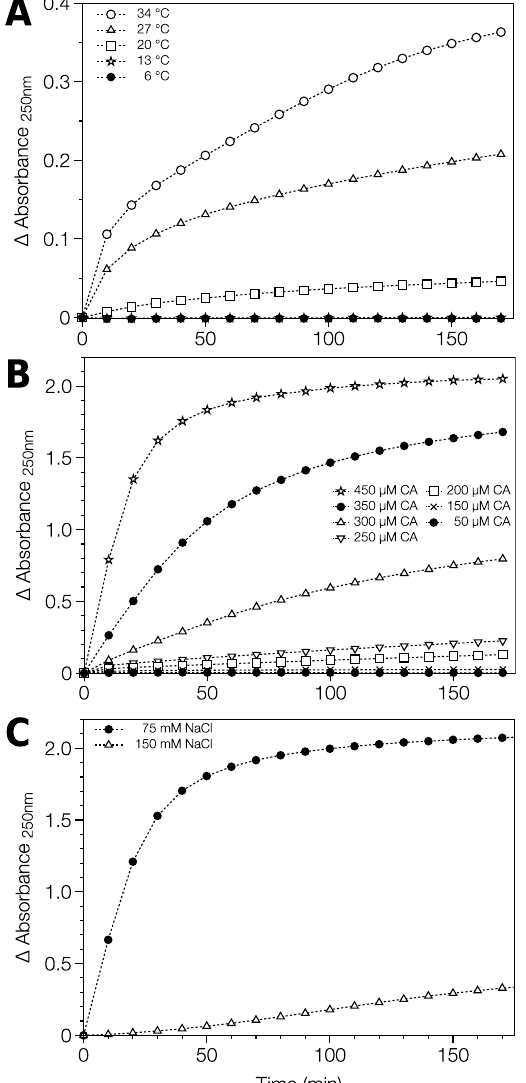
temperature. ( B ) Dependence on Protein Concentration. RSV CA (at varying concentration) in 12.5 mM MOPS/KOH pH 7.0, 75 mM NaCl, 10%(w/v) Ficoll 400 was incubated at 34 °C. ( C ) Dependence on